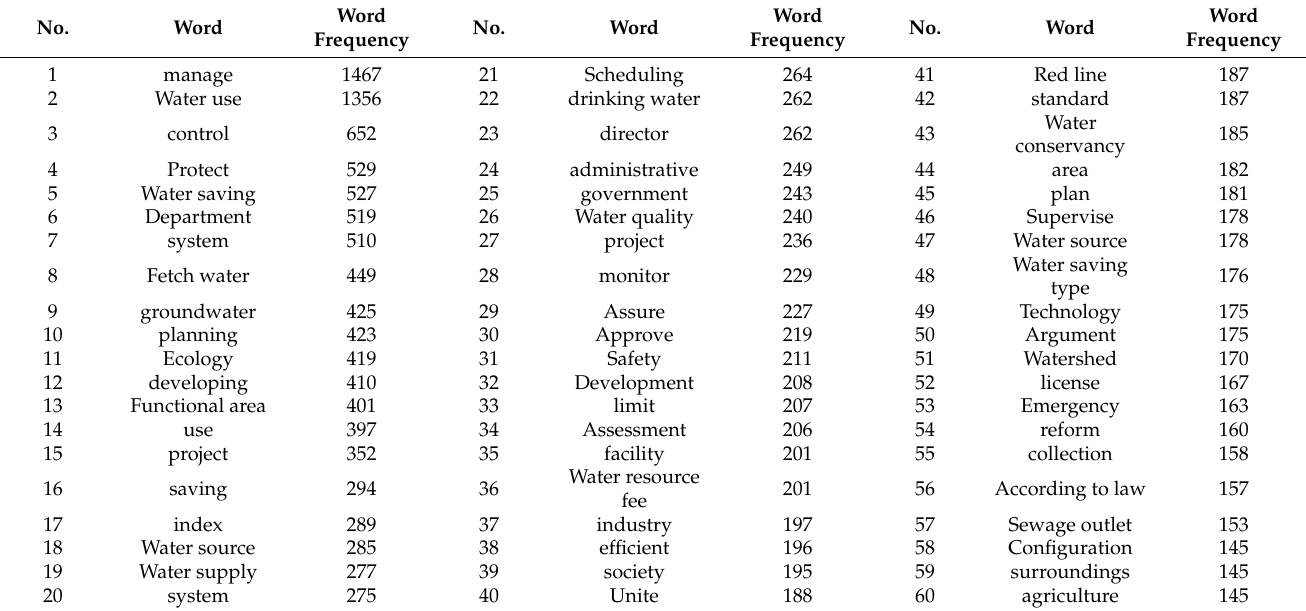
Table 4. Top 60 effective high-frequency words in policy